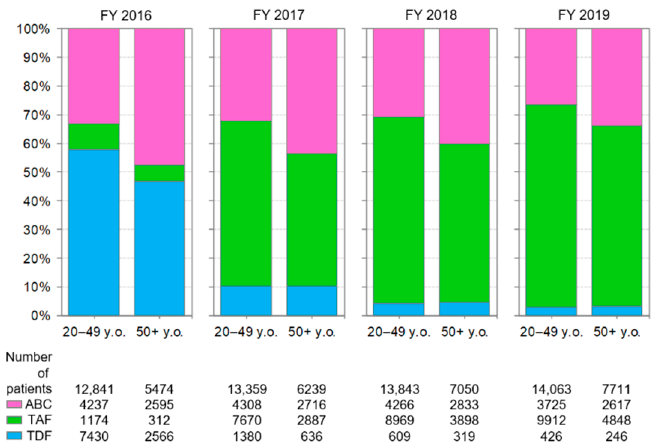
Figure 4. Changes in the prescriptions of backbone drugs by age group. The analysis was performed on drugs listed in Table 1. ABC: abacavir, TAF: tenofovir alafenamide fumarate, TDF: tenofovir disoproxil fumarate.